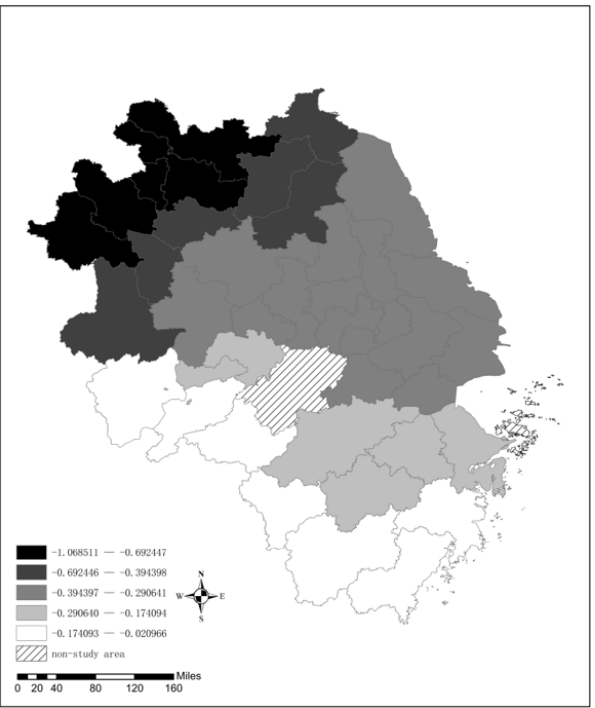
Figure 9. The spatial distribution of the regression coefficient for Inno .